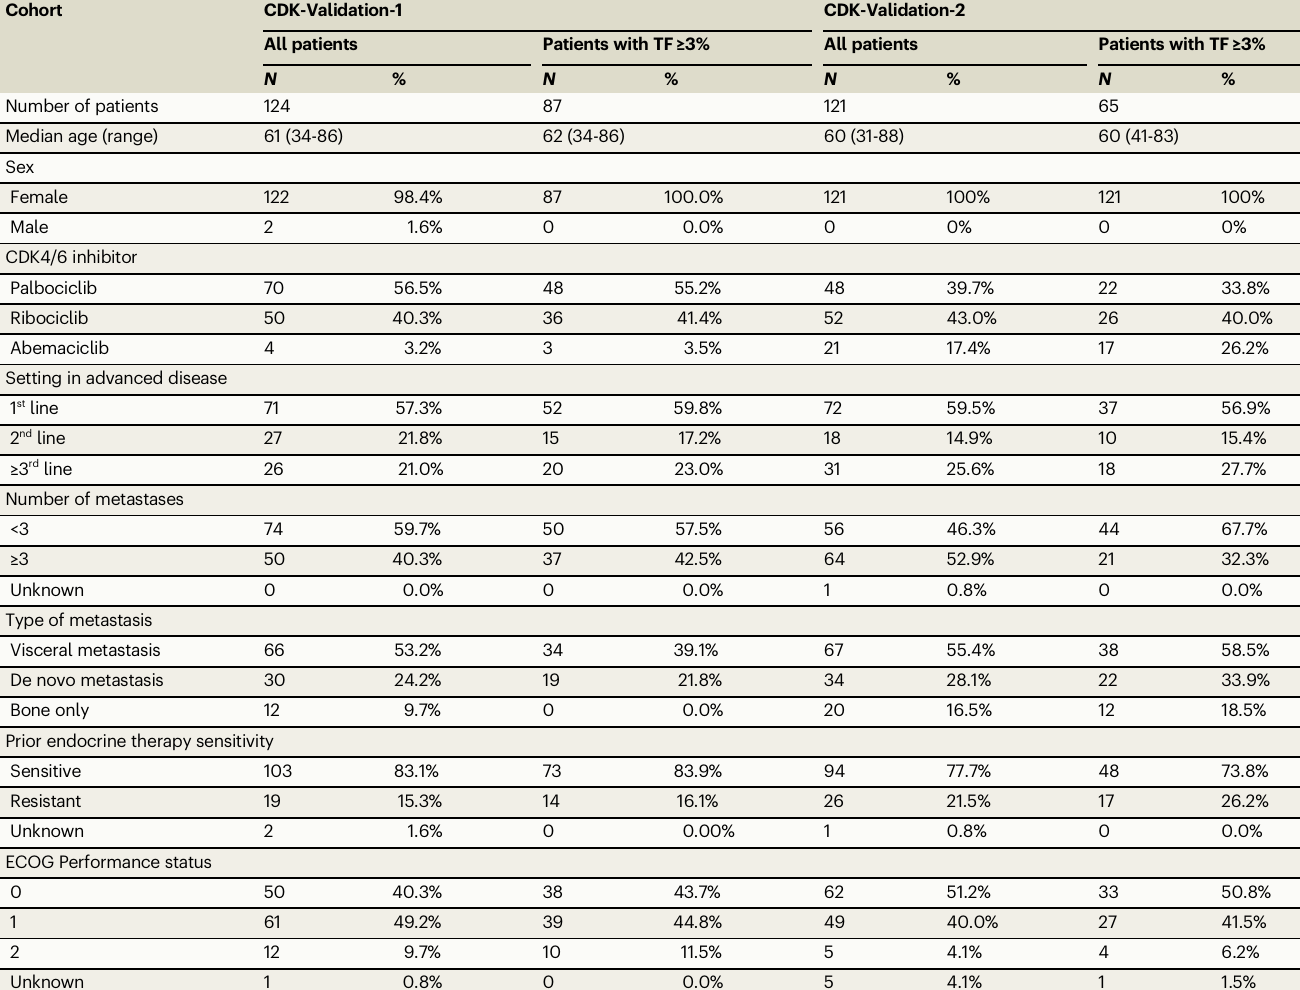
Table 2 | Baseline clinical characteristics of patients with HR+/HER2- advanced disease treated with endocrine therapy and a CDK4/6